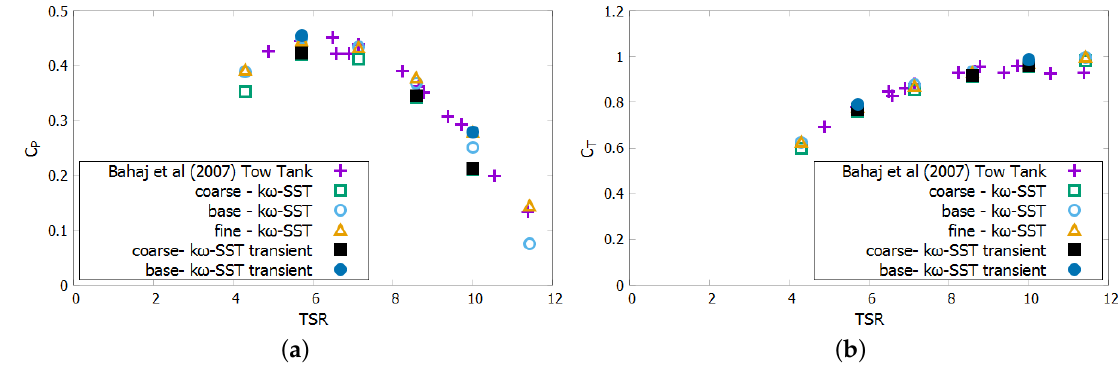
Figure 5. Steady state and transient results for freestream C P and C T as a function of TSR. ( a ) C P vs. TSR; ( b ) C T vs.